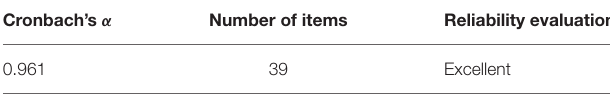
TABLE 4 | Reliability of the items related to safety culture.